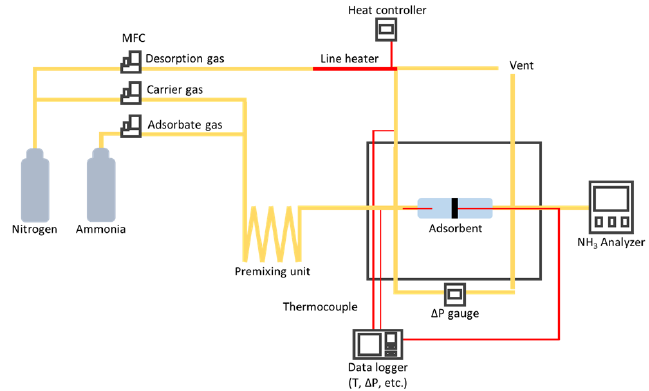
Figure 2. Schematic illustration of ammonia adsorption system.